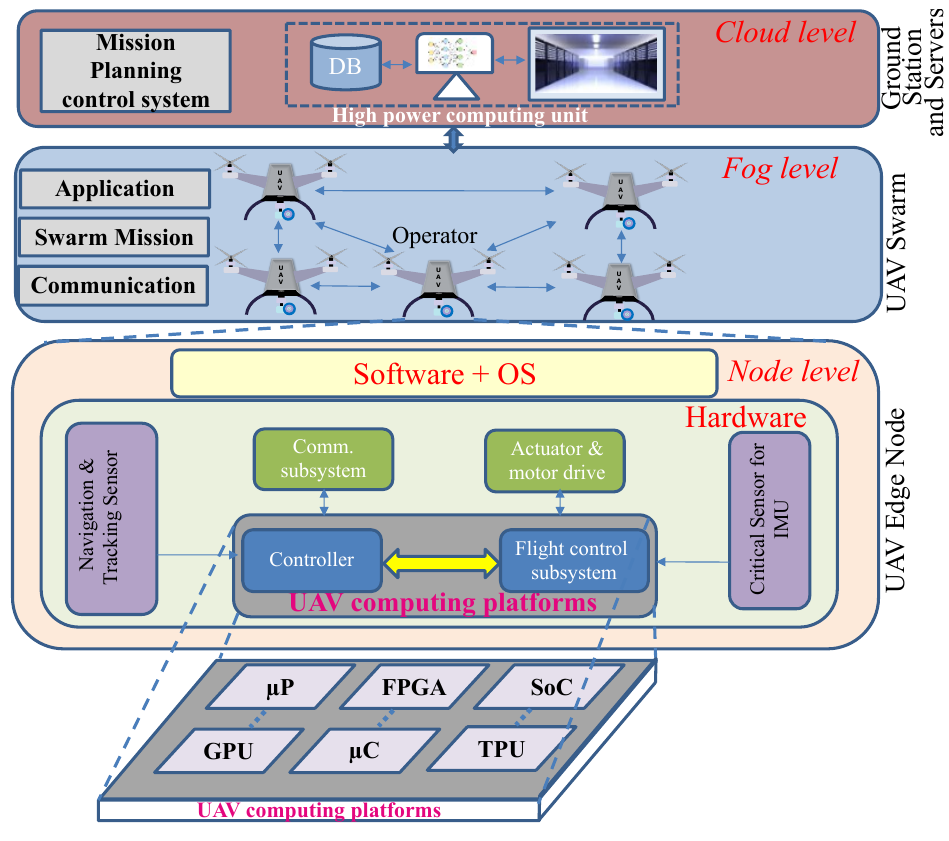
Figure 2. Basic overview of UAV